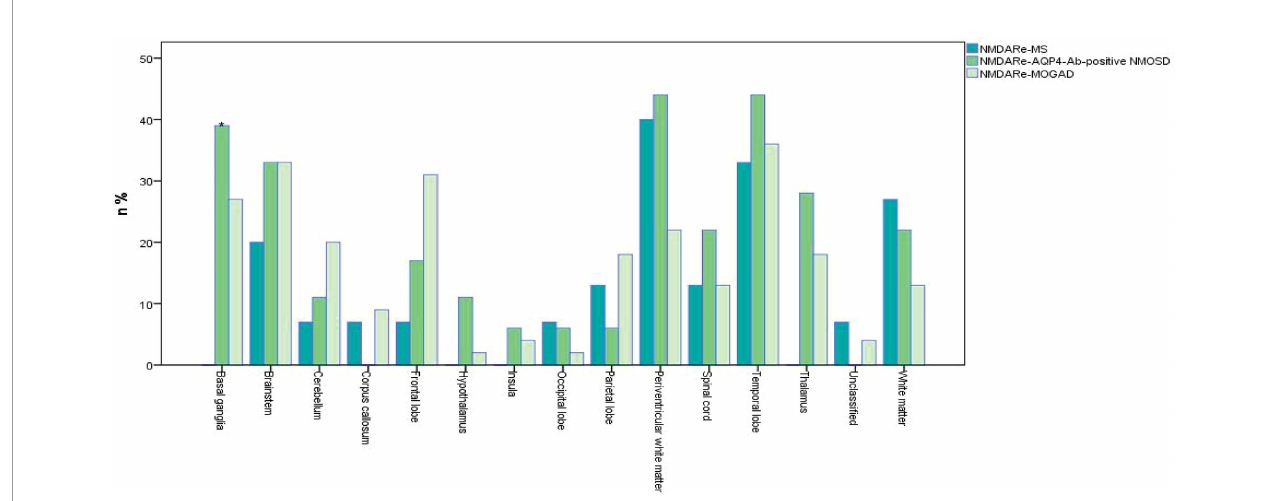
FIGURE 4 | Frequencies of MRI lesions in overlapping syndromes. *No basal ganglia involvement in patients overlapped with MS, p = 0.016. Unclassi fi ed meant no speci fi c details of MRI abnormalities in original references. White matter refers to all parts of the brain except the paraventricular white matter. Multifocal, infratentorial, and spinal cord involvement all were common in the three overlapping syndromes. Periventricular white matter was the most common lesion site in NMDARe overlapping with MS; periventricular white matter and the temporal lobe were the most common lesion sites in NMDARe overlapping with AQP4-Ab-positive NMOSD; the temporal lobe was the most common lesion site in NMDARe overlapping with